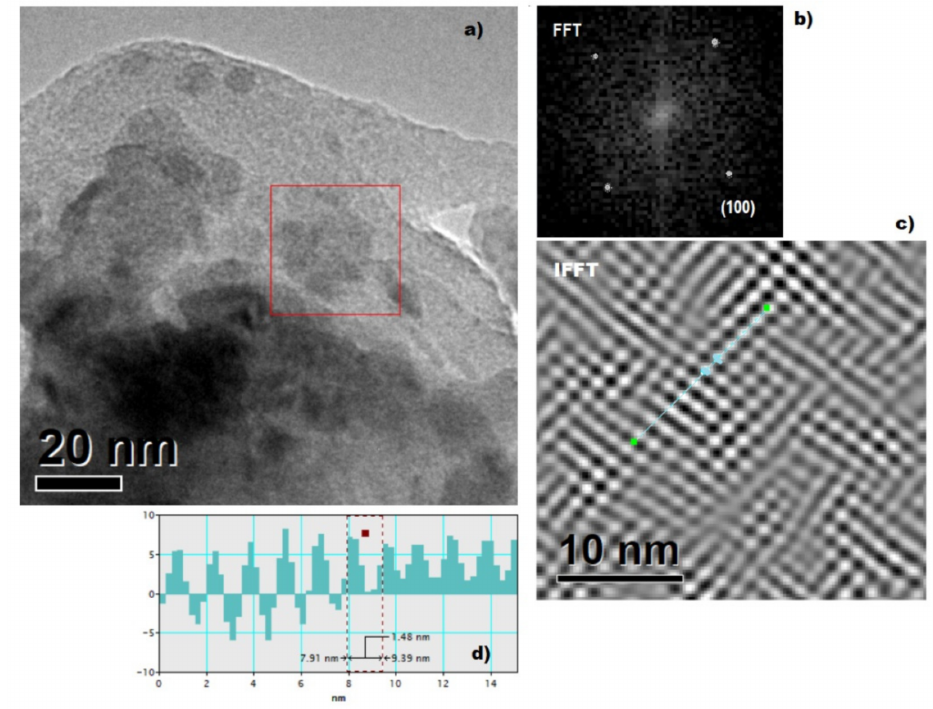
Figure 8. High-resolution transmission micrograph seen in an HRTEM. ( a ) Bright field, ( b ) Fast Fourier Transform (FFT), ( c ) Inverse Fourier Transform, ( d ) interplanar distance